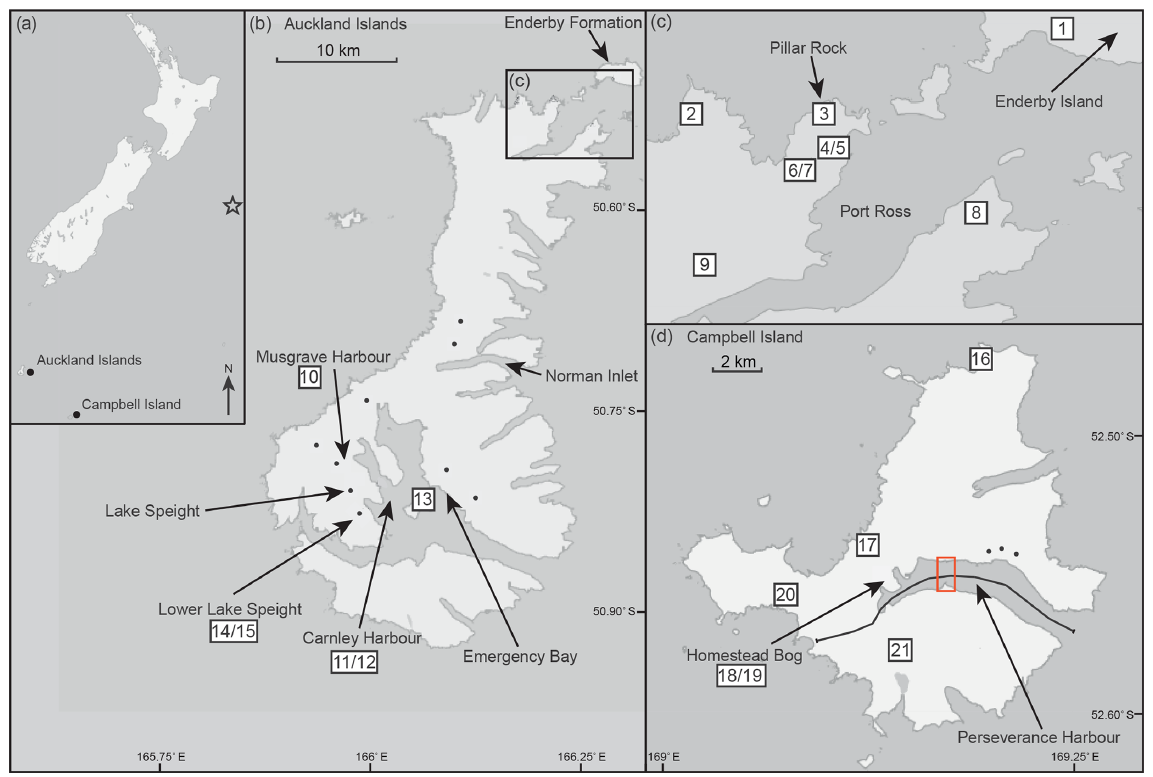
Figure 1. Map of Auckland and Campbell Islands. (a) Inset showing location relative to New Zealand mainland. Star shows location of ocean core DSDP 594 used in flow line modelling; (b) Auckland Islands. Black box marks location of panel (c) ; (c) inset showing northeast Auckland Islands; (d) Campbell Island. Model flow line marked along Perseverance Harbour, red rectangle highlights location of submerged moraines. Locations of basal peat radiocarbon ( 14 C) dates given by core numbers (see main text and Table 1). Key glacial cirques marked by black